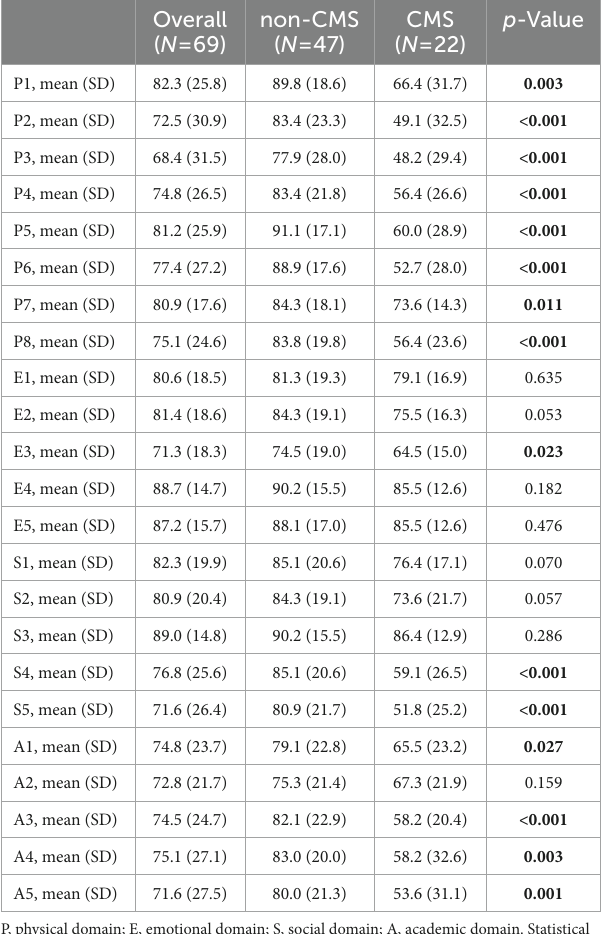
TABLE 4 Items comparison between CMS and non-CMS